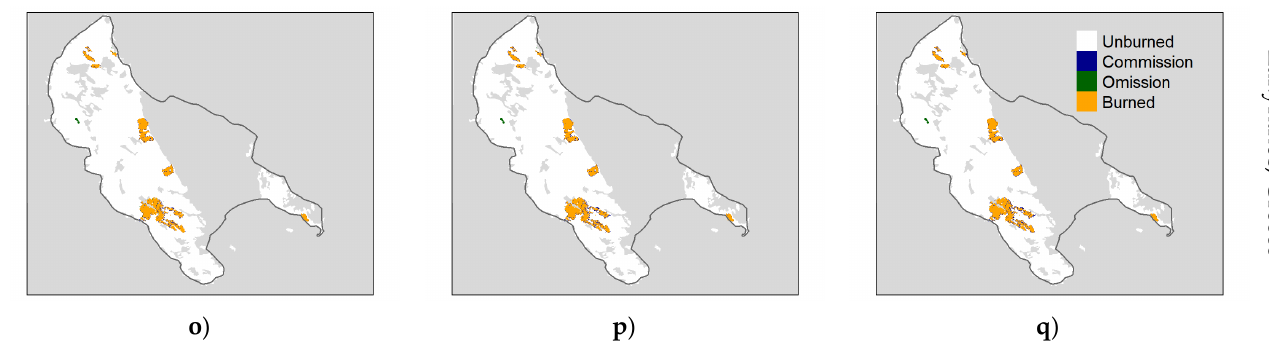
Figure 9. Agreement maps obtained for OWA Average (left column), OWA AlmostOR (middle column) and OWA OR (right column) over exportability sites: Leiria, Portugal ( a – c ), Calar, Spain ( d – f ), Huelva, Spain ( g – i ), Kalamos, Greece ( l – n ) and Zakynthos, Greece ( o – q ). The four classes represent: correctly classified burned pixels (orange), correctly classified unburned pixels (white), pixels mistakenly classified as burned—commission (blue) and pixel mistakenly classified as unburned—omission (green).